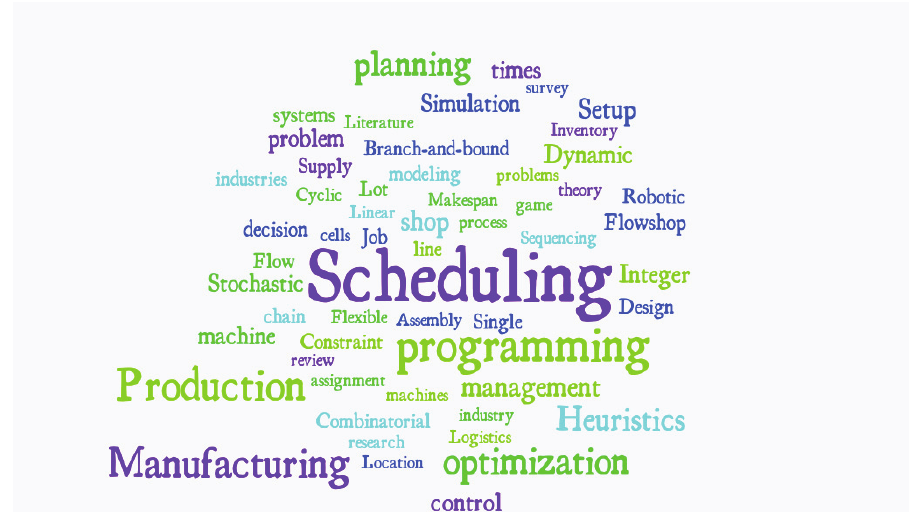
Fig. 4. The words cloud for single machine scheduling problem for AM in the five most important journals